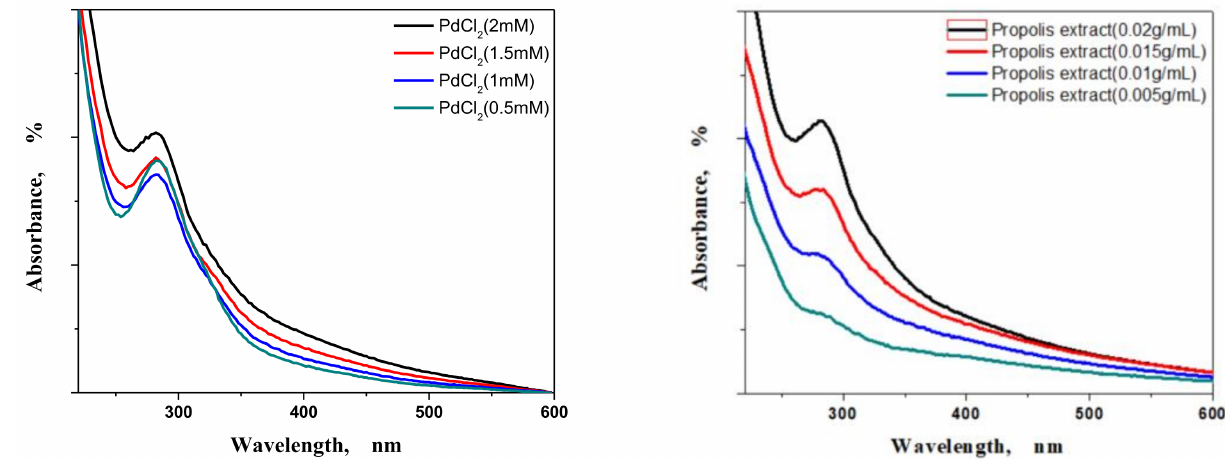
Figure 3. The effects of PdCl 2 and propolis extract concentrations on palladium nanoparticle biosynthesis.